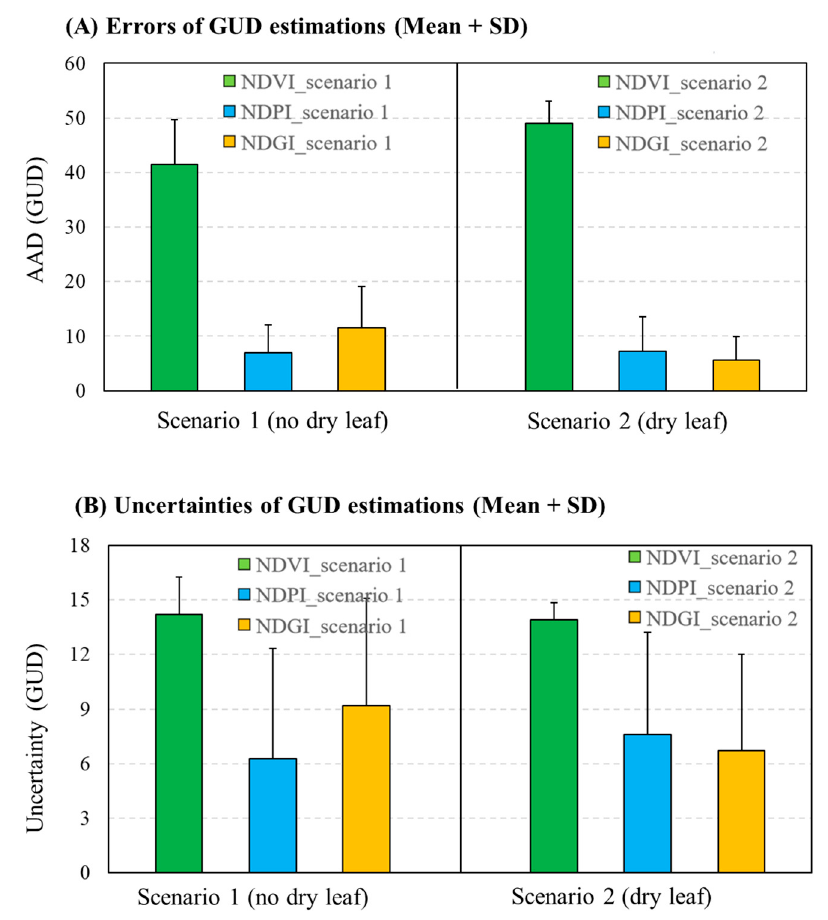
Figure 6. ( A ) the Average Absolute Difference ( AAD ) between the estimated green-up date (GUD) and true GUD from different vegetation indices; ( B ) GUD uncertainty for both simulation scenarios. The apparent error bar above each bar plot is defined as standard deviation (SD) of all estimations.